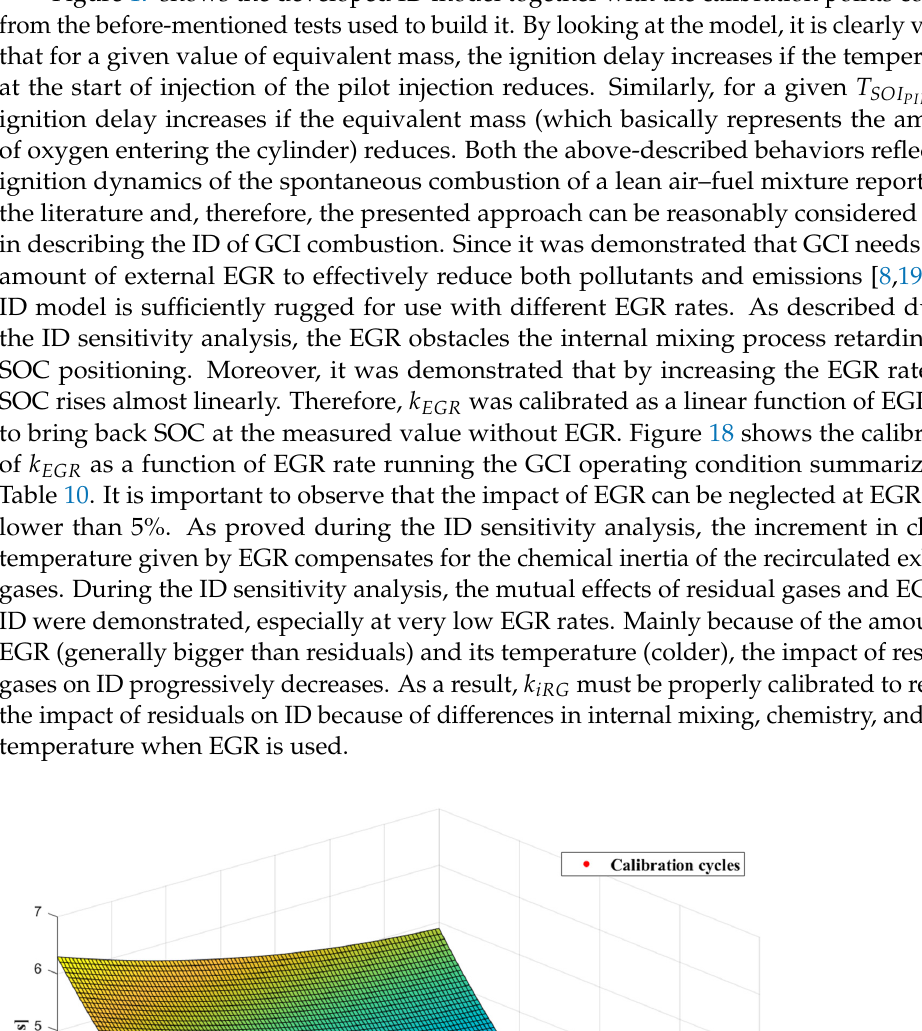
Figure 18. Calibration of 𝑘 𝐸𝑅𝐺 as a function of the EGR rate.